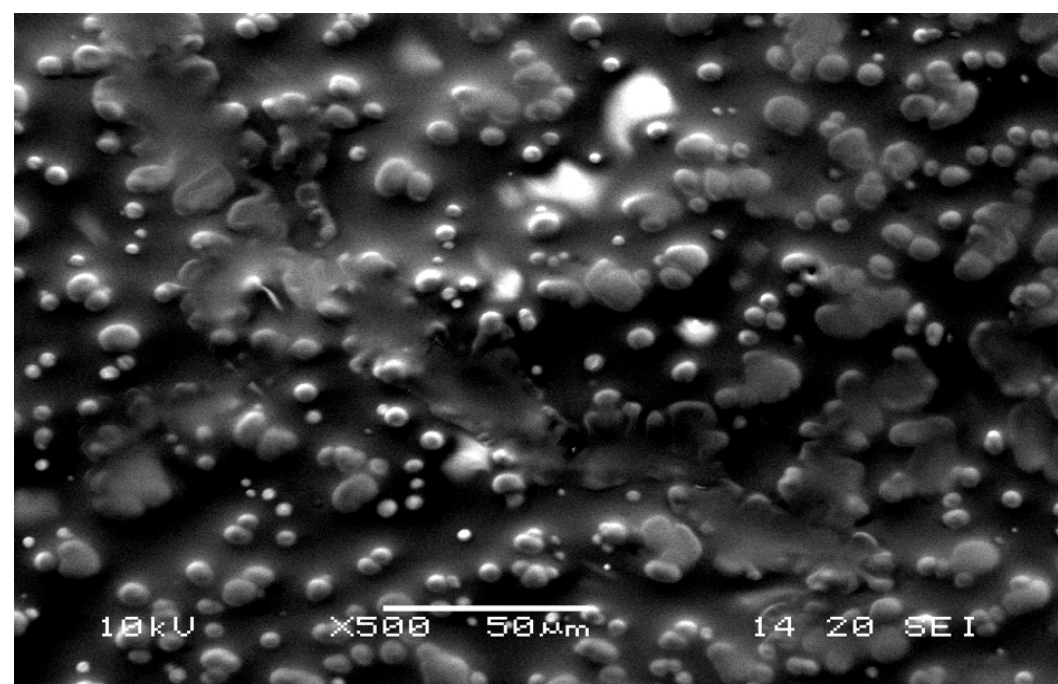
Figure 5. Preparation of rat aorta. Visible microspheres immersed in the vessel wall and a pass. Electron microscopy image (SEM, Jeol 5500LV, Akishima, Japan), 500 × magnification.